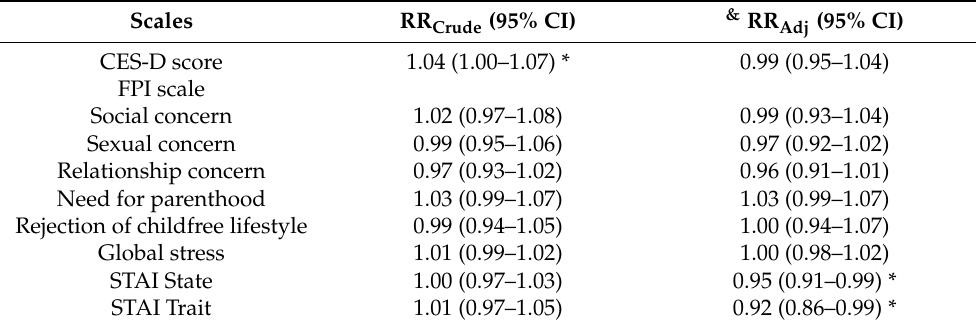
Table 3. Simple and multiple negative binomial regression analyses of psychological factors predict- ing IVF clinical